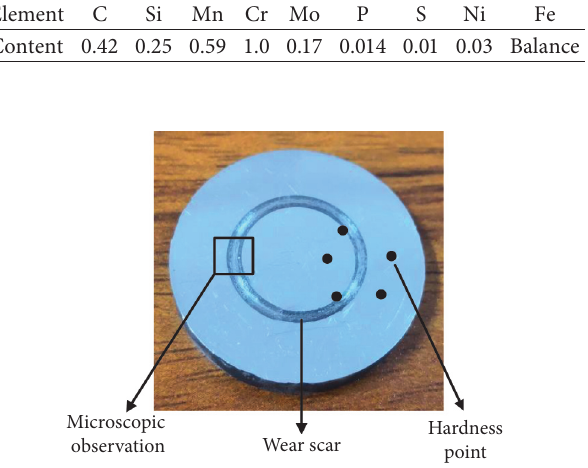
Figure 1: Schematic diagram of the conical pick.